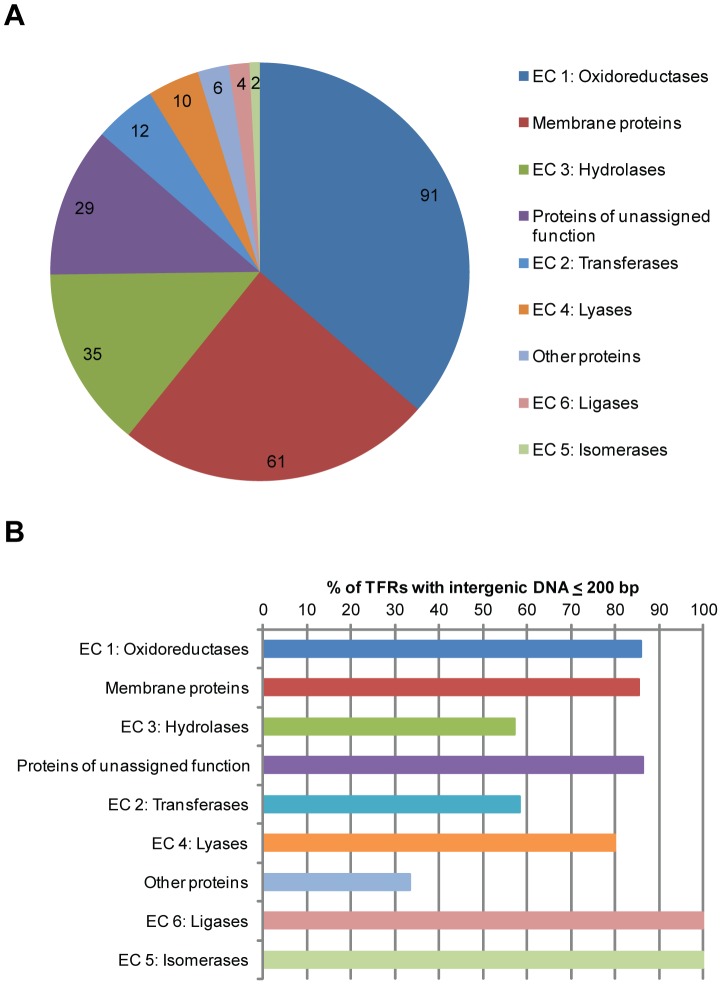
Diverse product types encoded by the divergent neighboring genes.(A) The number of TFRs adjacent to each type of divergent gene products – sorted by enzymes in six groups (EC 1 to EC 6), membrane proteins, other proteins (e.g. transcriptional regulators), and proteins of unassigned function. (B) TFRs were grouped according to their divergent gene type and the percentage of TFRs having intergenic DNAs ≤200 bp for each group is shown.